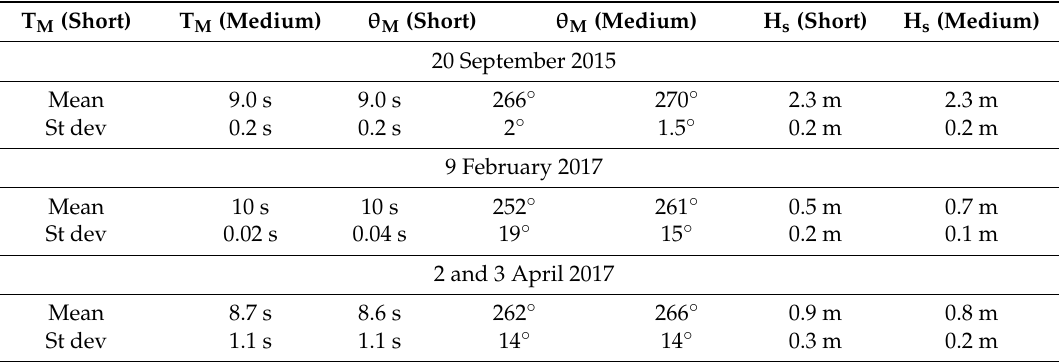
Table 4. Mean and standard deviation of the mean sea state spectral parameters obtained for each measurement